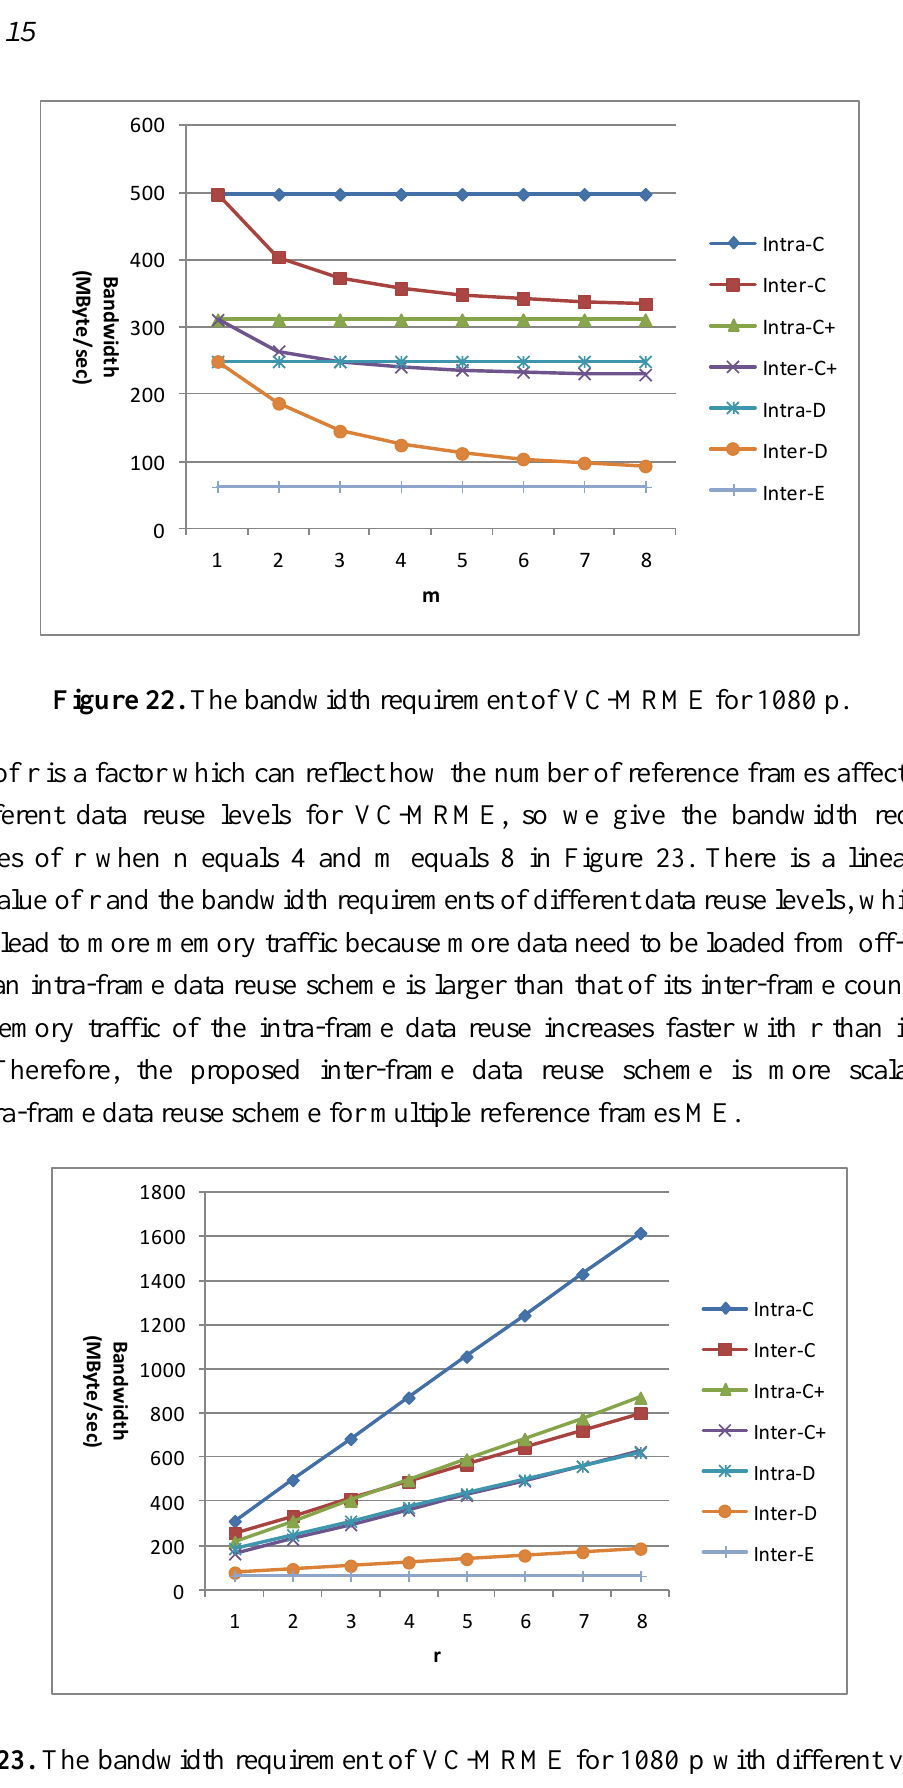
Figure 23. The bandwidth requirement of VC-MRME for 1080 p with different values of r. n equals 4 for C+ scheme. m equals